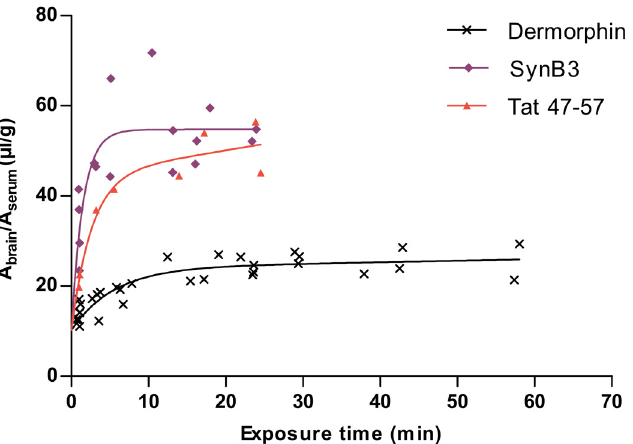
Fig 2. Result of the multiple time regression analysis experiment of SynB3, Tat 47 – 57 and dermorphin using the biphasic model. The ratio of the brain-to-serum activity is plotted versus the exposure time and fitted using the biphasic